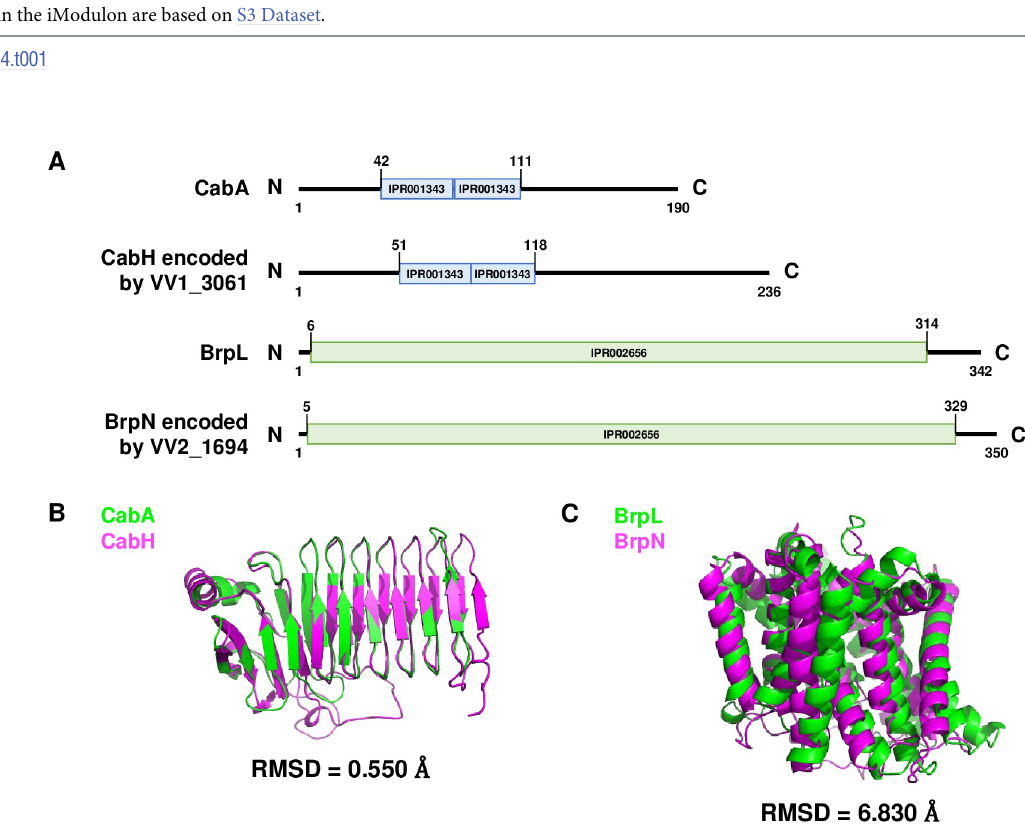
(magenta) (C). Protein structures were predicted by using the Alphafold2 algorithm and the superimpositions of the proteins were performed by using PyMOL. RMSD, root-mean-square deviation.